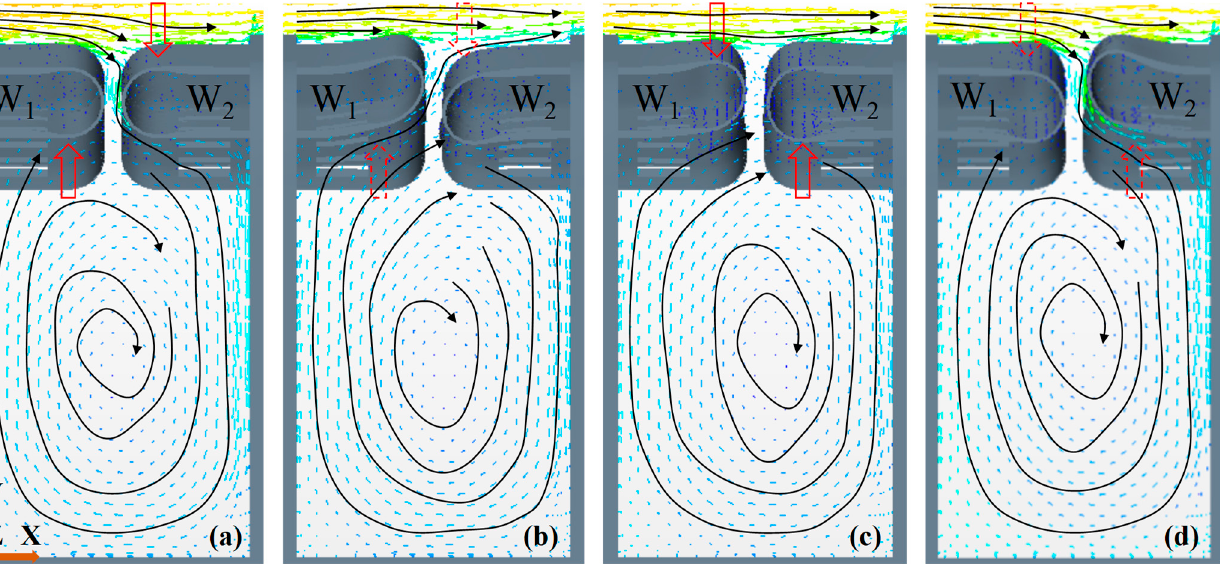
Figure 15. Characteristic morphology of flow-field movement and structure deformation during the vibration period: ( a ) initial state before vibration, ( b ) maximum displacement state of W1 eversion, ( c ) intermediate state of W1 rebound, ( d ) maximum displacement state of W2 eversion.